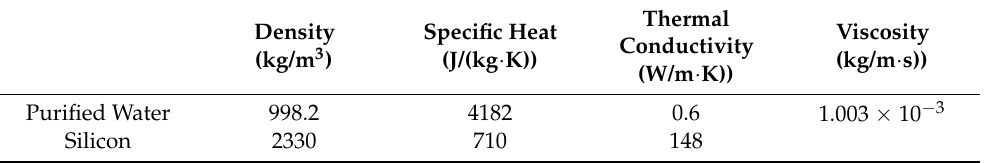
Table 3. Material selection and the corresponding physical